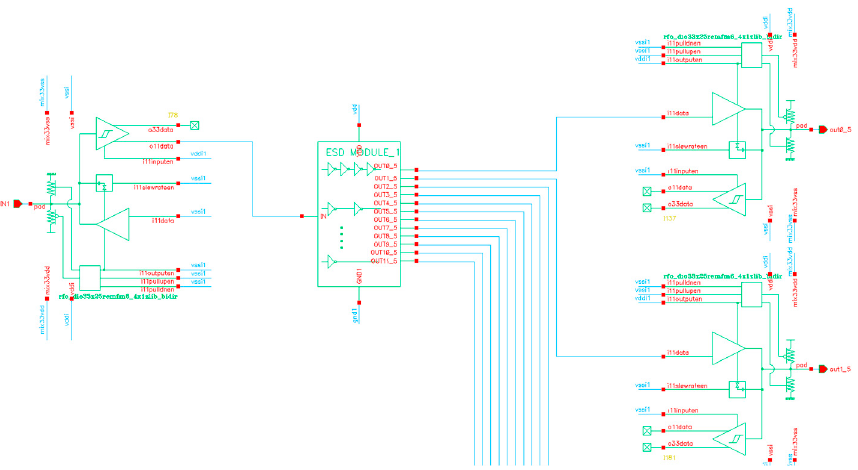
Figure 7. Example of inputs and outputs (I/Os) as connections for bidirectional cells.